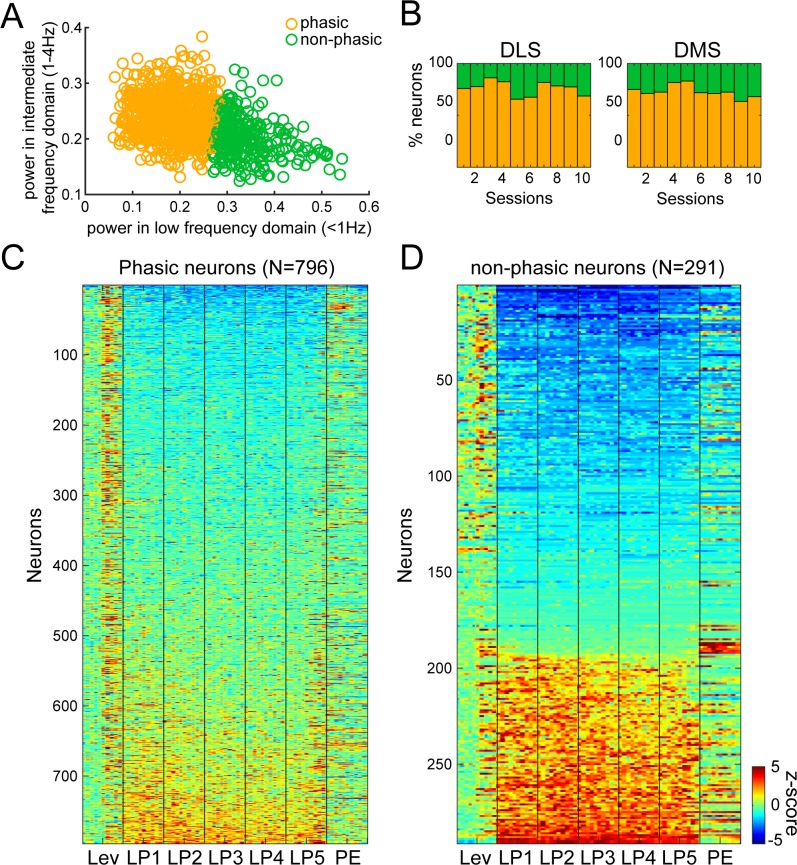
Fourier analysis and hierarchical clustering allowing separation of Phasic and Non-phasic neurons during early training.(A) Scatter plot of normalized power in low (<1 Hz) and intermediate (1–4 Hz) frequency ranges illustrating the separation of Phasic neurons (orange circles), and Non-phasic neurons (green circles). (B) Proportion of Phasic and Non-phasic neurons across early training sessions in DLS (left) and DMS (right). (C–D) Heatmaps of neural activity of Phasic (C) and Non-phasic neurons (D).